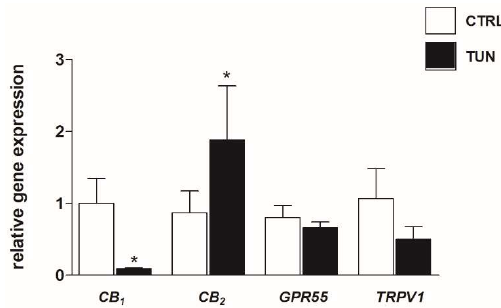
Figure 1. Effect of tunicamycin on mRNA expression of endocannabinoid (eCB)-binding receptors. SH-SY5Y cells were treated for 24 h with 1 µg/mL tunicamycin (TUN). Data are presented as means ± SEM (n = 3). [* p < 0.05 vs. control cells (CTRL)].